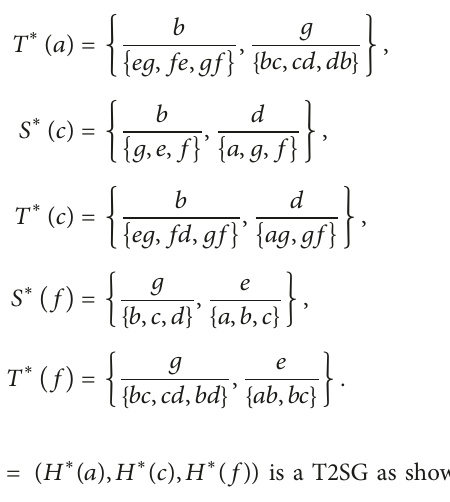
Figure 3: G ∗ = (𝐻 ∗ (𝑒 1 ),𝐻 ∗ (𝑒 2 ),𝐻 ∗ (𝑒 3 )) .